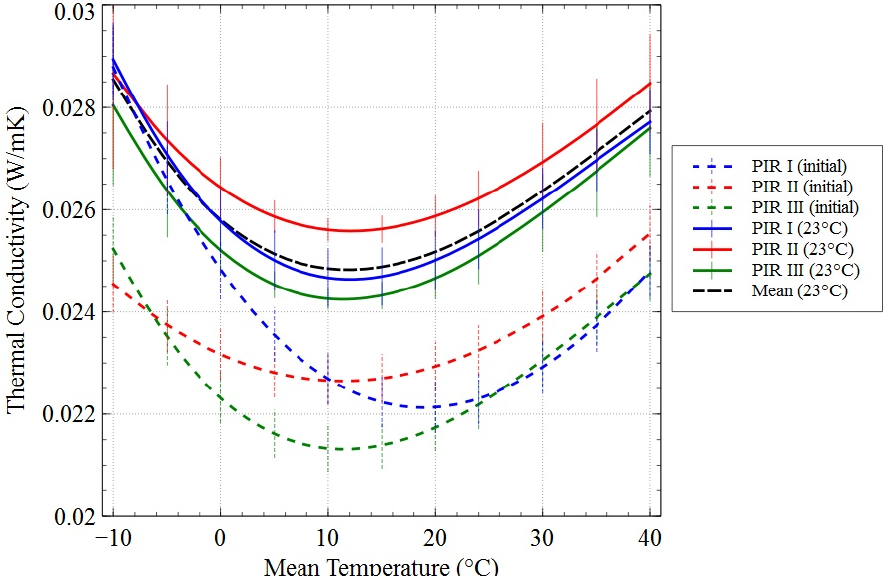
Figure 5. Thermal conductivity as a function of mean temperature for PIR specimens conditioned at 23 ◦ C for the equivalent of 5 years in comparison to initial measurements.